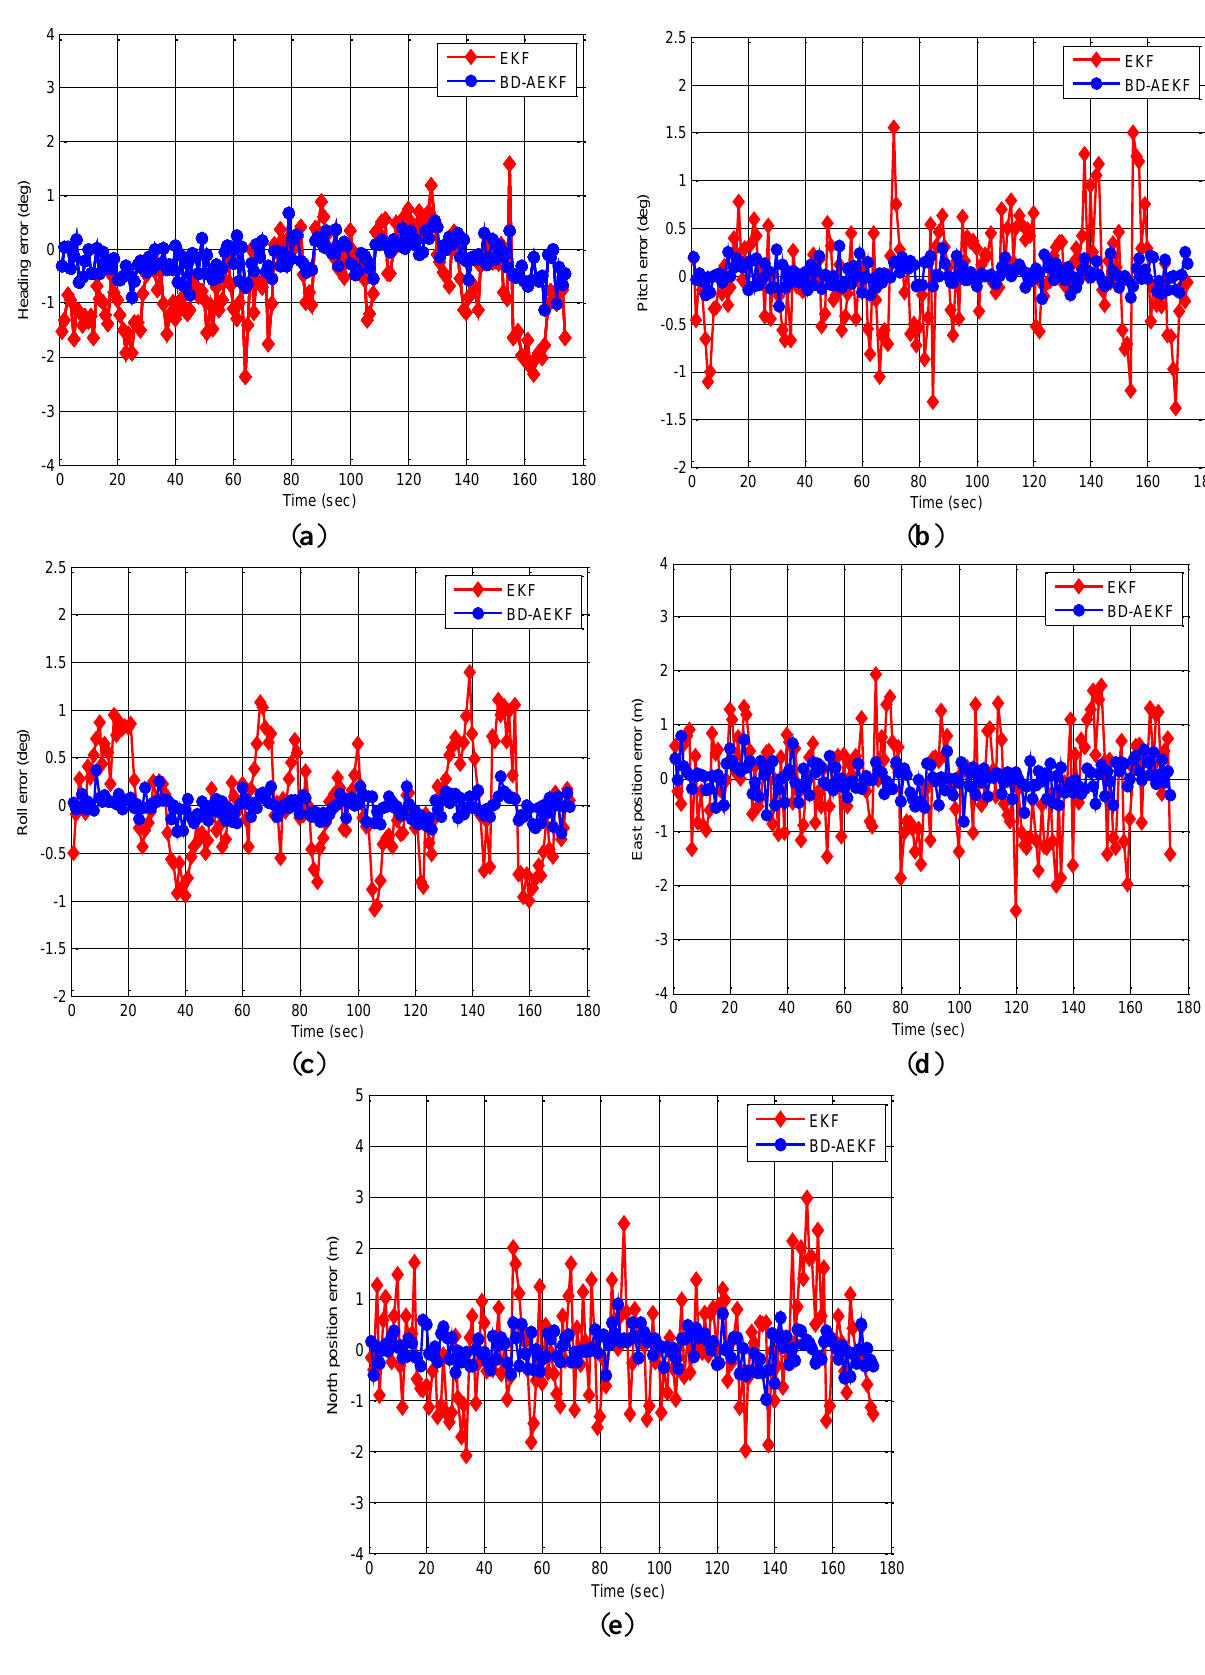
Figure 8. The errors for EKF and BD-AEKF in the rectangle trajectory. ( a ) Heading ( b ) Pitch ( c ) Roll ( d ) East position ( e ) North